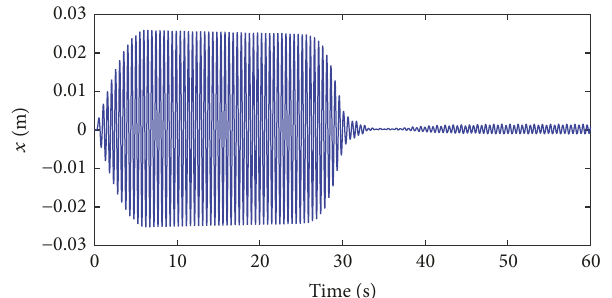
Figure 9: Experimental response for the primary system obtained with the optimal parameters.